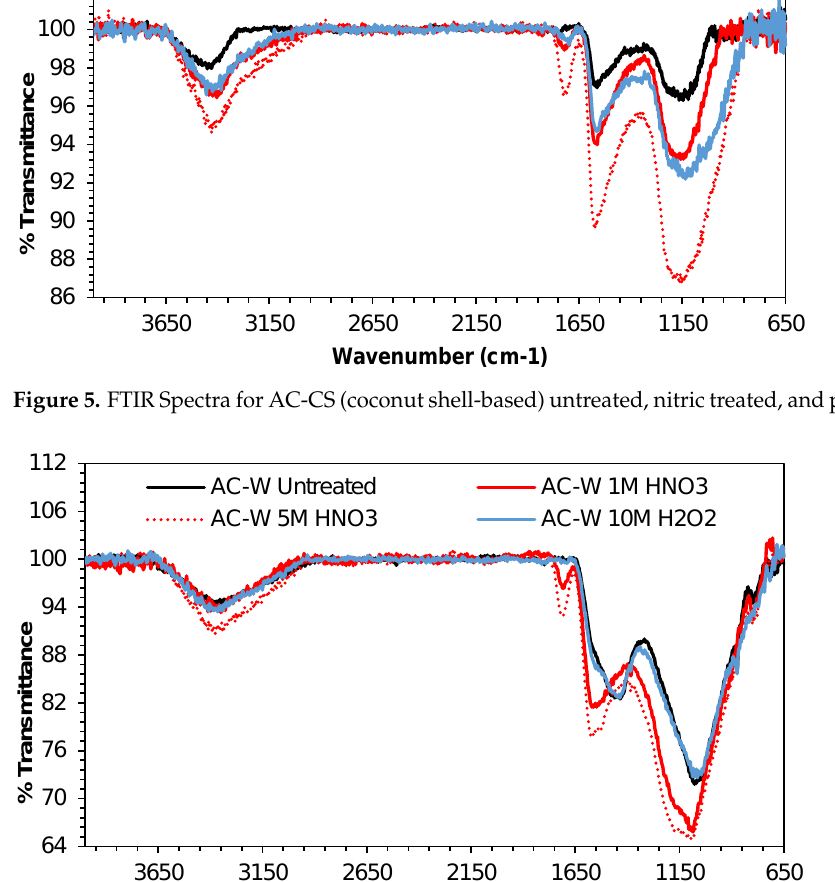
Figure 5. FTIR Spectra for AC-CS (coconut shell-based) untreated, nitric treated, and peroxide treated.